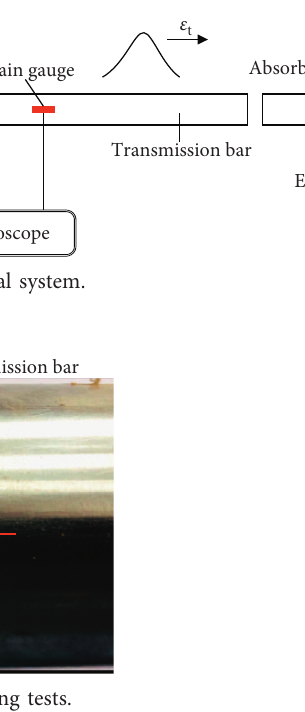
Figure 1: Schematic of the NSCB marble specimen.